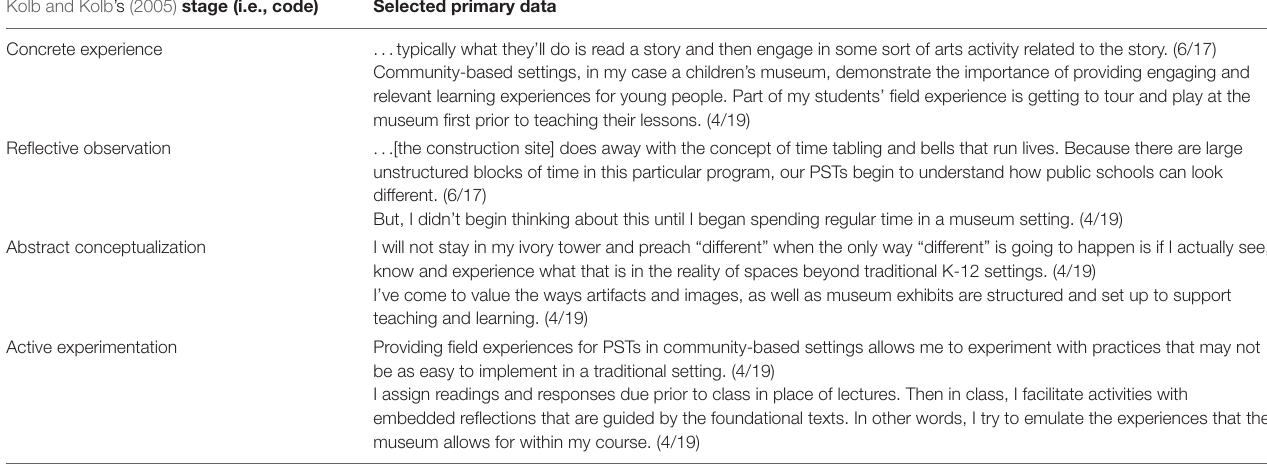
TABLE 6 | Kolb and Kolb (2005) ELT stages coding. Kolb and Kolb’s (2005) stage (i.e., code) Selected primary data Concrete experience